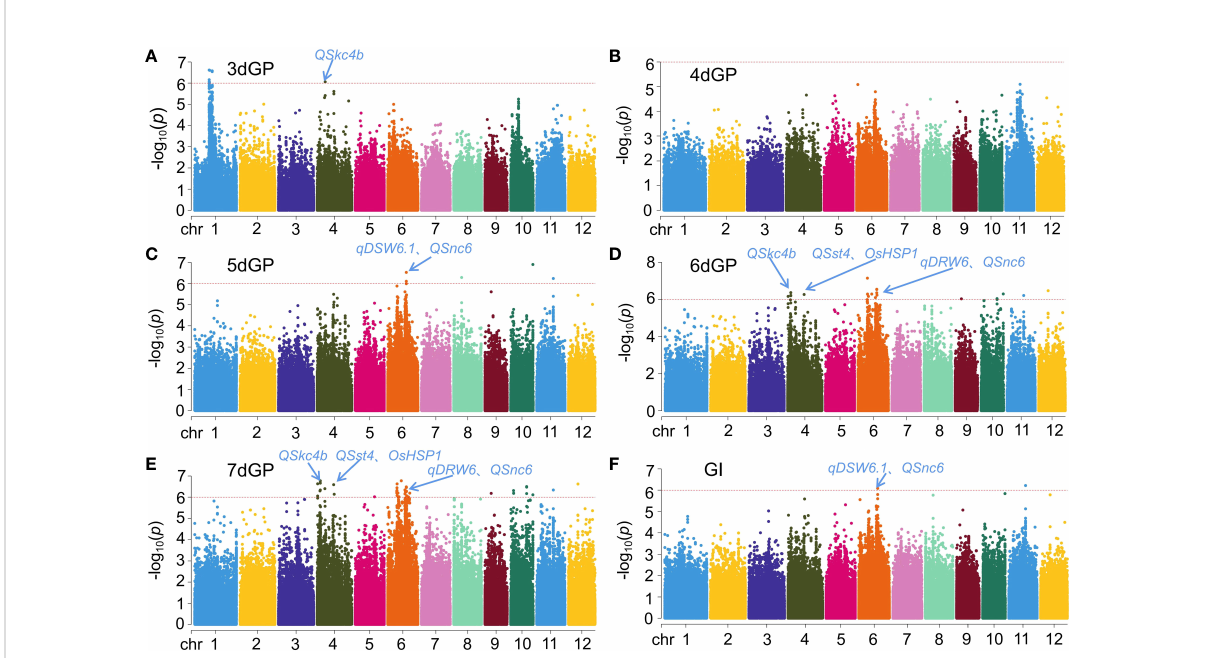
FIGURE 3 Results for GWAS of germination potential (GP) on different days and germination index (GI) under salt stress. (A) GP on day 3 (3dGP). (B) GP on day 4 (4dGP). (C) GP on day 5 (5dGP). (D) GP on day 6 (6dGP). (E) GP on day 7 (7dGP). (F) GI.